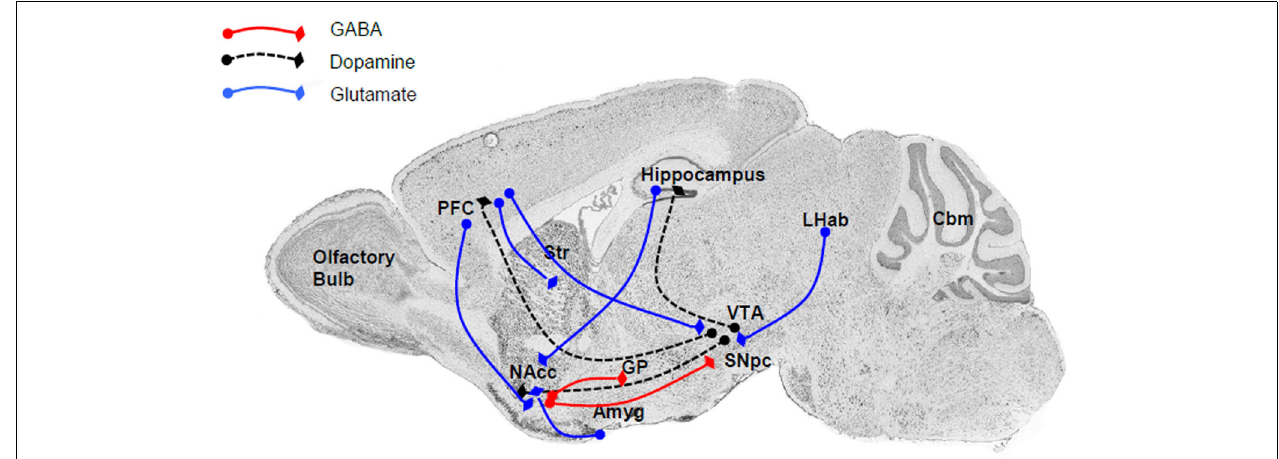
FIGURE 1 | The major connections within the reward and aversion circuitry are regulated by P2X4Rs either directly or indirectly. Within these neuroanatomical regions P2X4Rs either colocalized to neuronal cell bodies or localized to glia and modulate the release of various neurotransmitters. Major neurotransmitters and their pathways include (i) dopamine (black dash) linking the VTA with the NAcc (ventral striatum), PFC, and hippocampus; (ii) glutamate